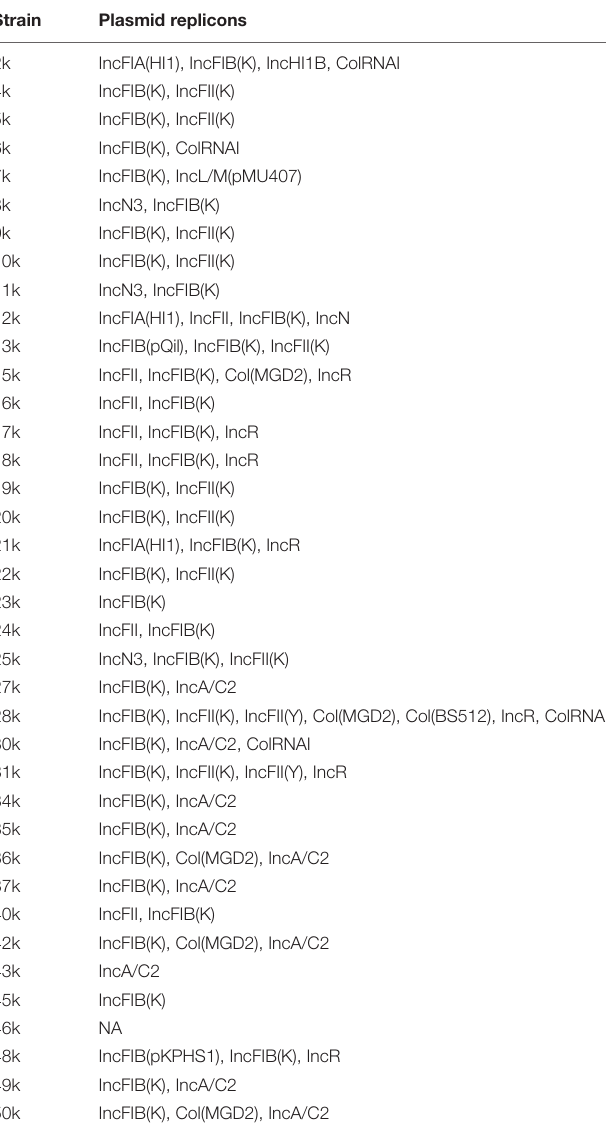
TABLE 3 | Plasmid replicons found in K. pneumoniae